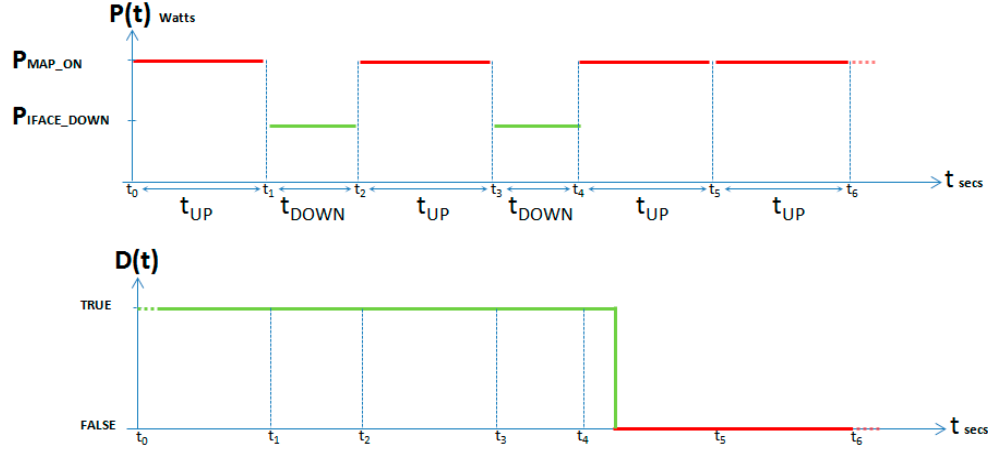
Figure 4. Power consumption variation related to D(t).